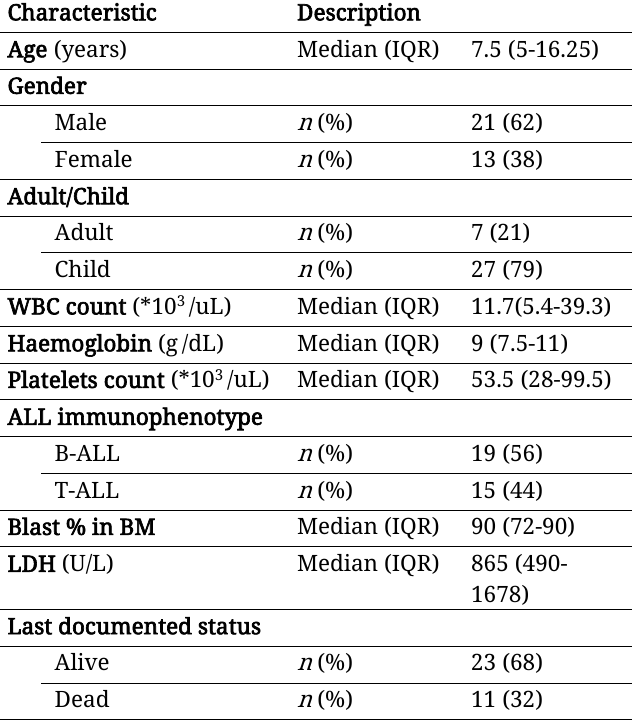
Table 1: Characteristics of 34 ALL patients